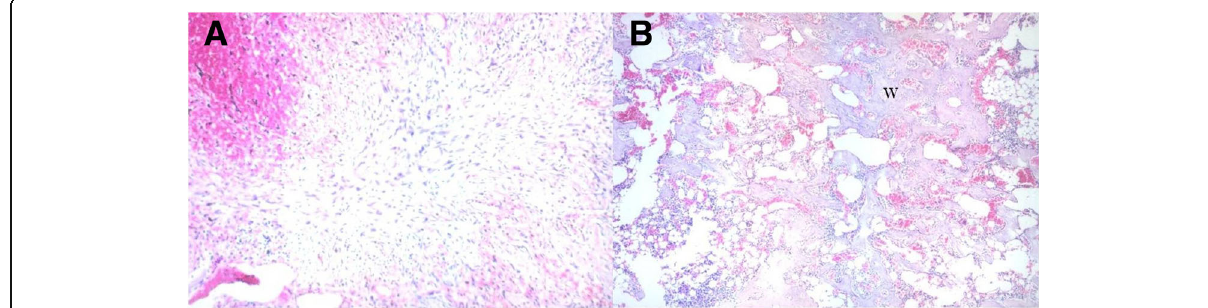
Fig. 3 Hematoxylin- and eosin-stained histological sections of Steroid group. a Tibial healing delayed and the bleeding and necrosis were detected on day 3 (X100). b The marrow cavity filled with woven bone instead of trabecular on day 15 (X40). T , trabecular bone; W , woven bone; Ob ,